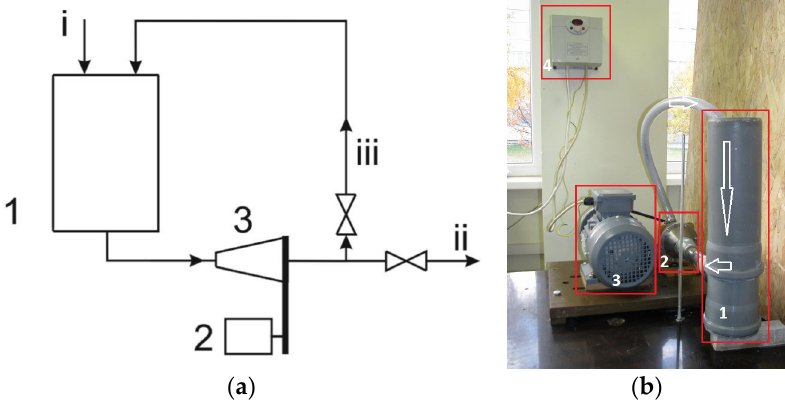
Figure 1. Scheme of the experimental setup for Cu 2+ -containing wastewater treatment. Principal scheme ( a ) 1—container for suspension; 2—engine; 3—mixer-disperser; i—supply components to be mixed; ii—suspension output; iii—recycle stream. General view ( b ) 1—container for suspension; 2—mixer-disperser; 3—engine; 4—engine rpm control unit Arrows indicate suspension circulation directions.